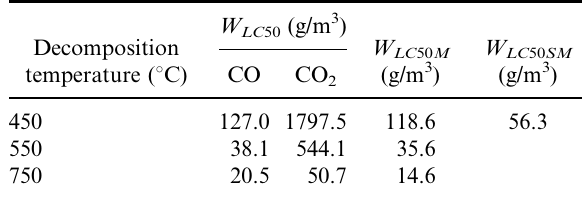
Table 8. Toxicometric indicators of modified polyester